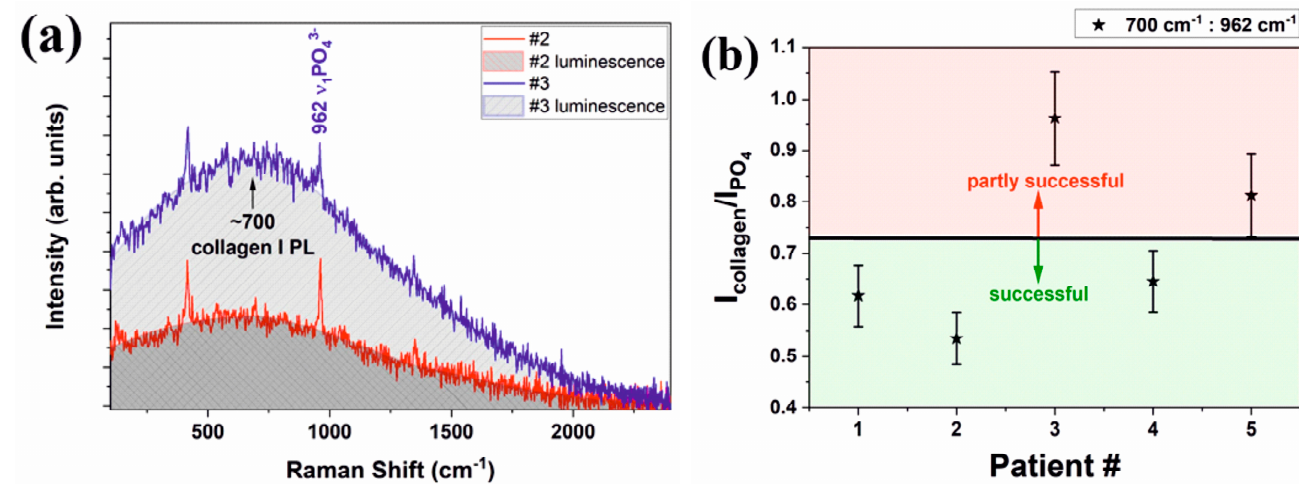
Figure 4. ( a ) The in vivo Raman spectra of patients #2 and #3 that have different status showing the bands used in quantification; ( b ) the results of quantifications performed in this study based solely on in vivo Raman spectra.